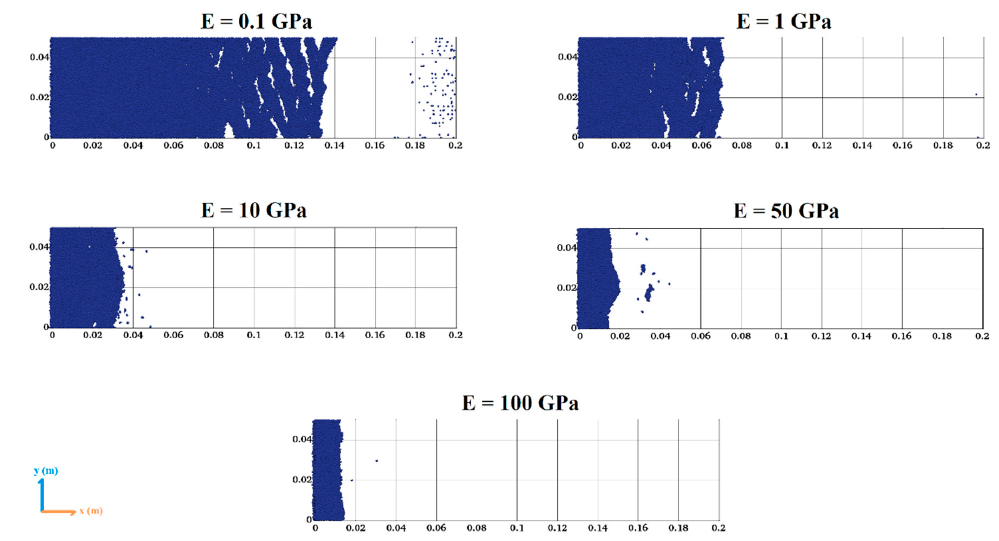
Figure 11. Successful fracture sealing in all simulated cases of Young’s moduli.